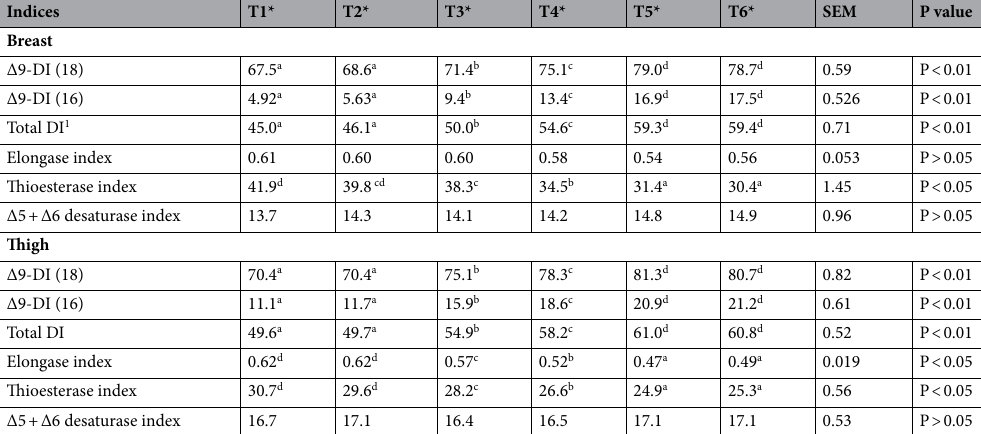
Table 3. Effect of dietary supplementation of Bifidobacterium bifidum (BFD) and Mannan-oligosaccharides (MOS) on lipid metabolism indices of broiler chicken (n = 6 × 2). *T1 (no BFD/MOS/BMD), T2 (20 mg